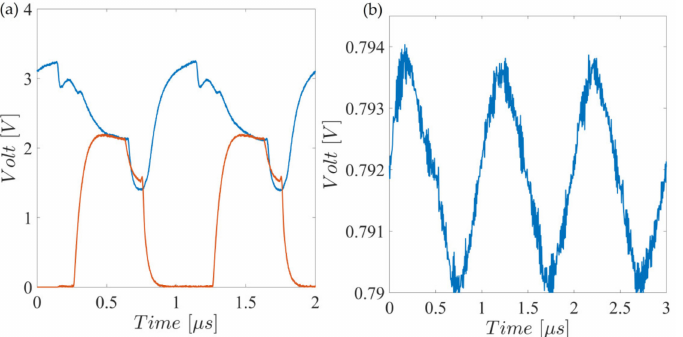
Figure 11. ( a ) Demodulator input (blue) and transistor drain (red) signals. ( b ) Demodulated signal output, continuous component, and